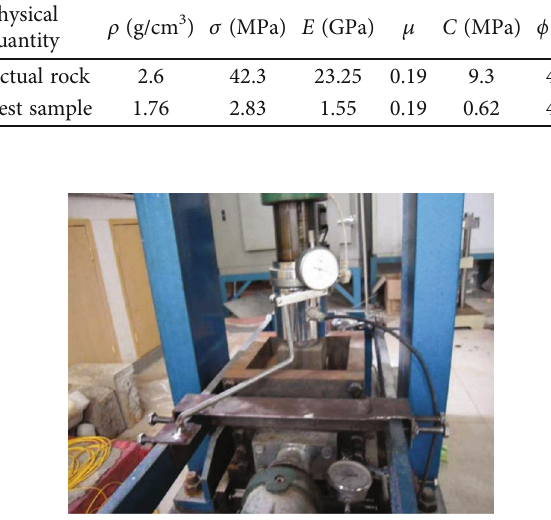
Figure 1: Homemade cyclic shear apparatus for rock mass testing.